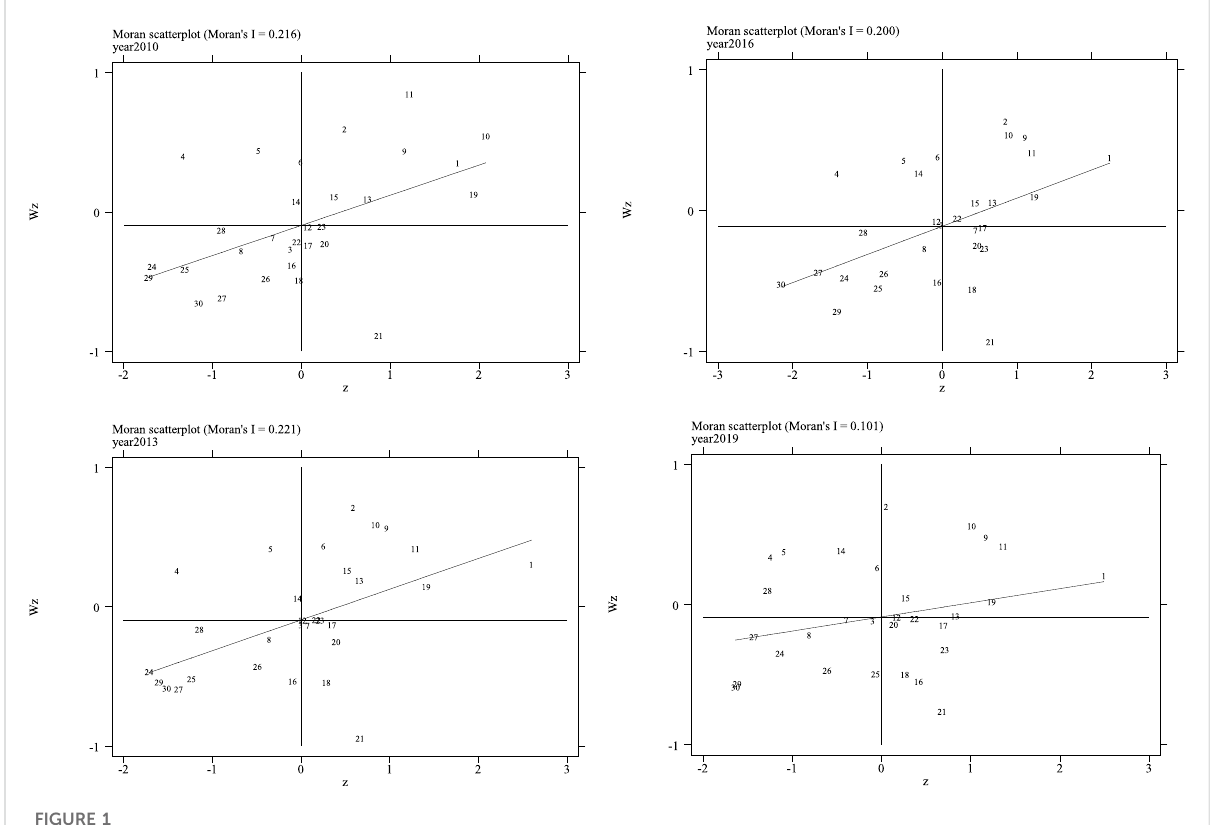
FIGURE 1 Local Moran ’ I scatter diagram of carbon emission ef fi ciency of China ’ s provinces in 2010, 2013, 2016, and